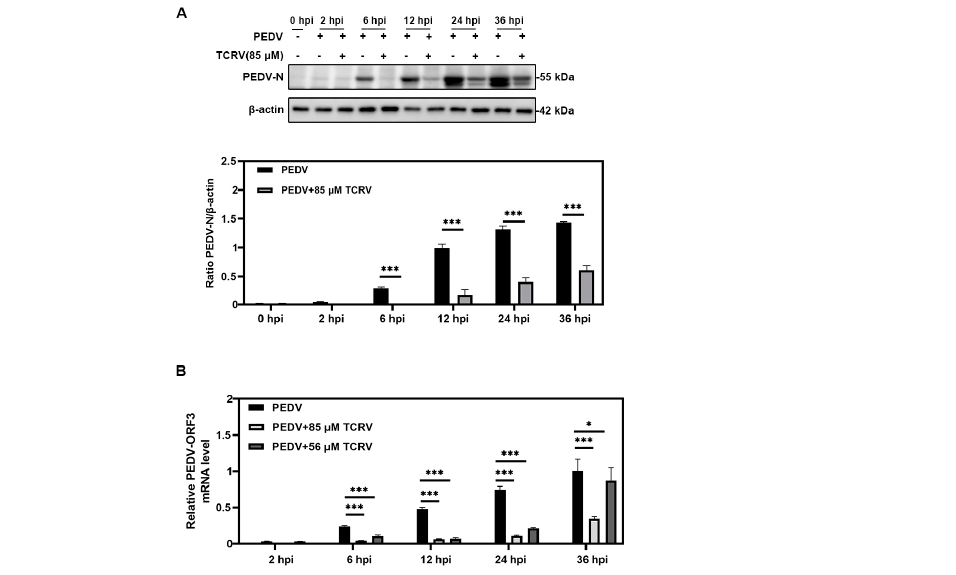
Figure 2. Inhibitory effect of TCRV on PEDV infection at different time points. ( A ) PEDV-infected cells treated with TCRV at different concentrations at 2, 6, 12, 24, and 36 hpi were analyzed by Western blotting. The PEDV N protein band was quantified as the ratio of the band intensities of PEDV N protein to β -actin in Western blotting. ( B ) PEDV-infected cells treated with TCRV at different concentrations at 2, 6, 12, 24, and 36 hpi were analyzed by RT-qPCR. Data from three independent